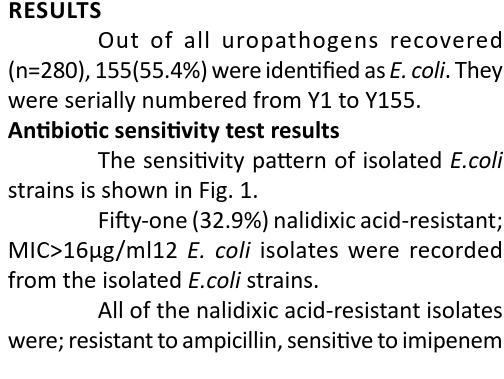
Table 3. The MICs of the isolates for ciprofloxacin (N=51) (CLSI, 2014) Table 2. Results of the disc diffusion test of the Nalidixic MIC No. of S/ I /R % acid-resistant isolates (N=51) (CLSI, 2014) (µg/ml) isolates Antibiotic No.of resistant % ≤0.064 8 isolates 0.125 19.6 Nalidixic acid (30ug) 51 100.0 51 100.0 ≥32 30 R MICs (µg/ml) were determined by E.test; R, resistant; I, intermediate; and S,